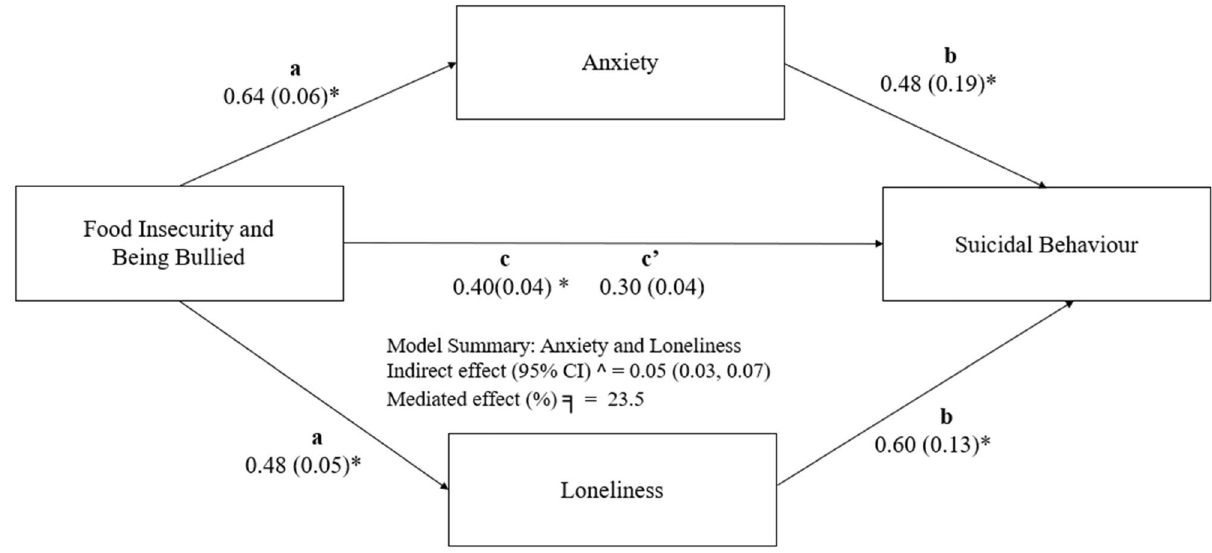
Figure 1. Mediating role of anxiety and loneliness symptoms on the relationship of food insecurity and being bullied on suicidal behavior. Values outside the parentheses are unstandardized path coefficients, whereas those in the parentheses are standard errors. Path ( a ) represents the coefficient for the effects of the main variables on the mediators (anxiety and loneliness), Path ( b ) the coefficient for the effects of the mediators (anxiety and loneliness) on suicidal behaviour after the main independent variables are adjusted for, and Path ( c ′ ) the effects of the main independent variable (food insecurity and being bullied) on suicidal behavior when the mediators (anxiety and loneliness) are adjusted for. CI confidence interval. ^ = bias-corrected confidence interval. ╕ = proportion of total effect mediated. *p <